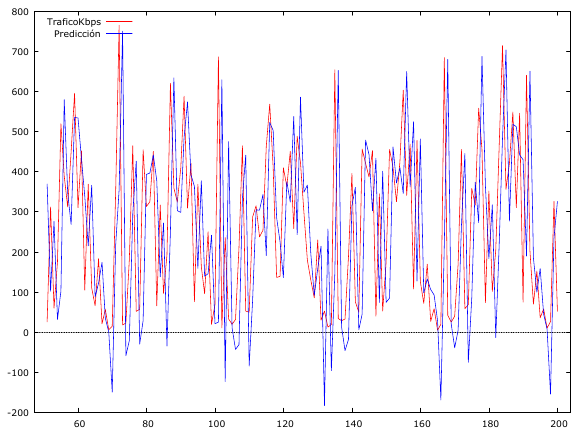
Figure 8. Prediction of the SARIMA model (1,1,1) (0,1,2) (32).